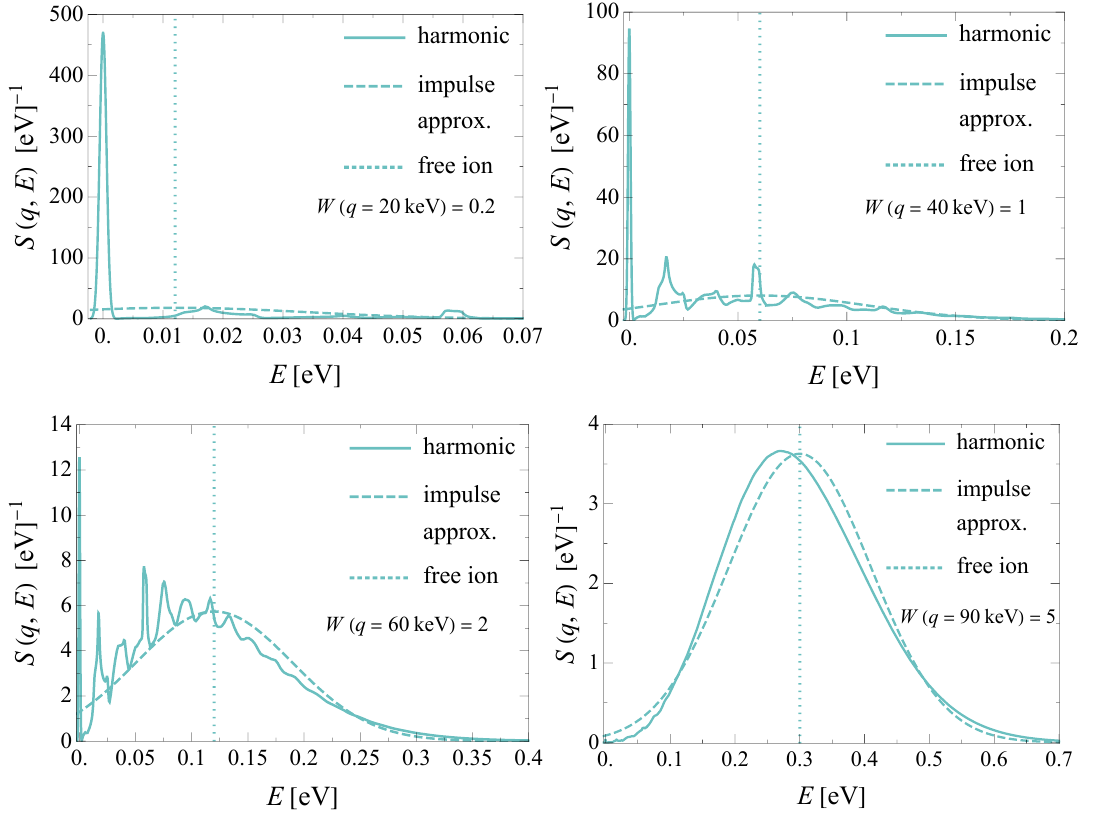
Figure 4. Dynamic structure factor, S ( q, E ) , in silicon as a function of energy deposition, E , and for different values of the momentum transfer, q . We show the changes in S ( q, E ) as the momentum transfer transitions from the small ( W ( q ) (cid:28) 1 ) to the large momentum ( W ( q ) (cid:29) 1 ) regime. To illustrate the relative contribution of the elastic term in eq. (4.5) we convolve it with a Gaussian √ envelope, S 0 ( q, E ) = e − 2 W ( q ) δ ( E ) → e − 2 W ( q ) e − E 2 / 2 δ 2 / 2 πδ 2 , where we set δ 2 = 10 − 3 ˜∆ 2 . Note that for the bottom right figure, q = 90 keV, the purely elastic scattering with E = 0 is negligible, but it becomes increasingly important for lower momentum